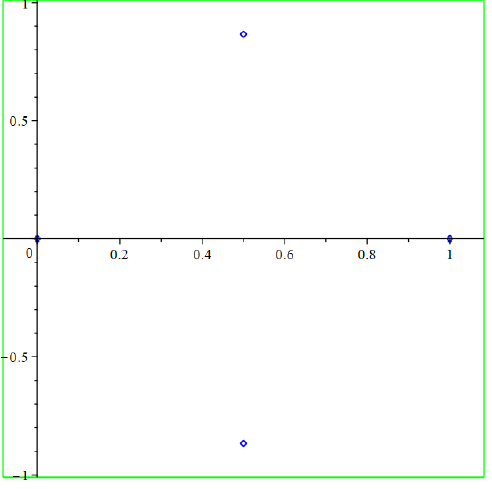
Figure 16. Maple output for locus equation P ( x , y ) =